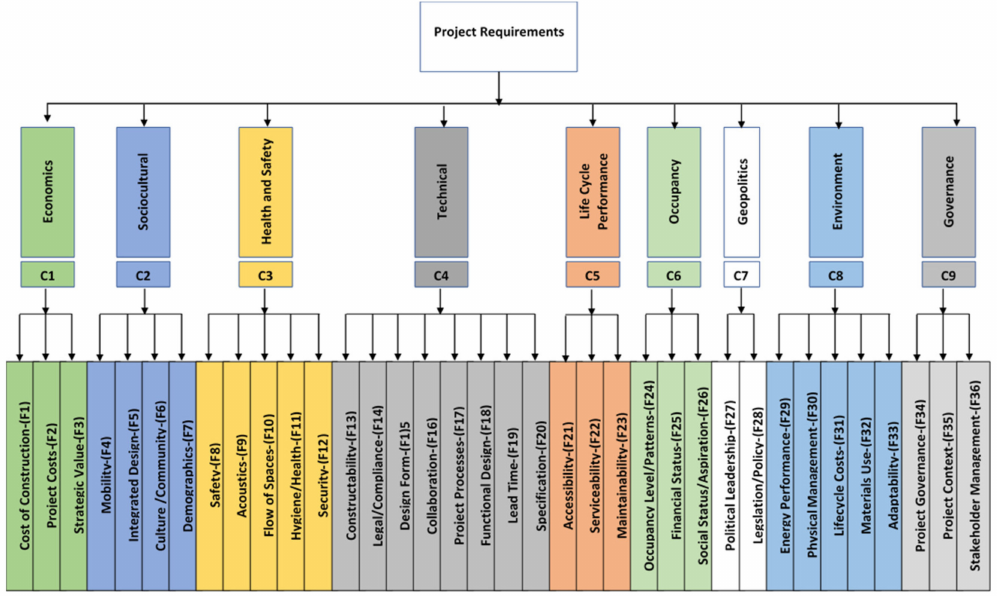
Figure 7. Summary of categories and factors of Design